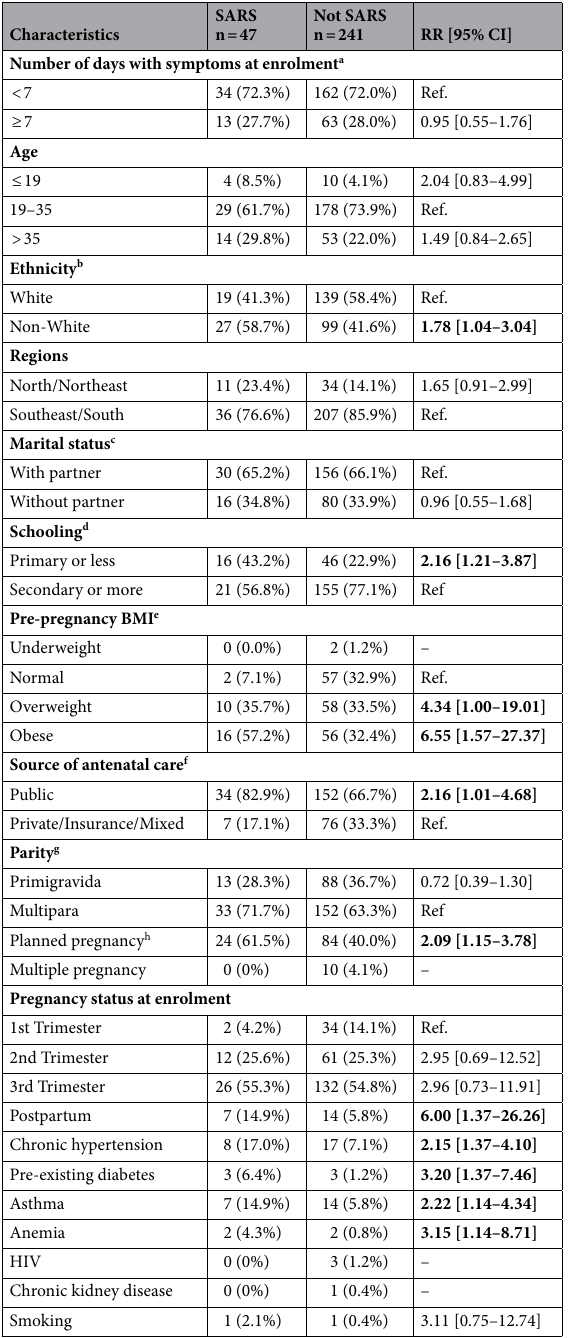
Table 4. Bivariate analysis for risk factors associated to severe acute respiratory syndrome (SARS) in women with confirmed COVID-19. Missing information for a 16, b 4, c 6, d 50, e 87, f 19, g 2, h 39. Significant values are in